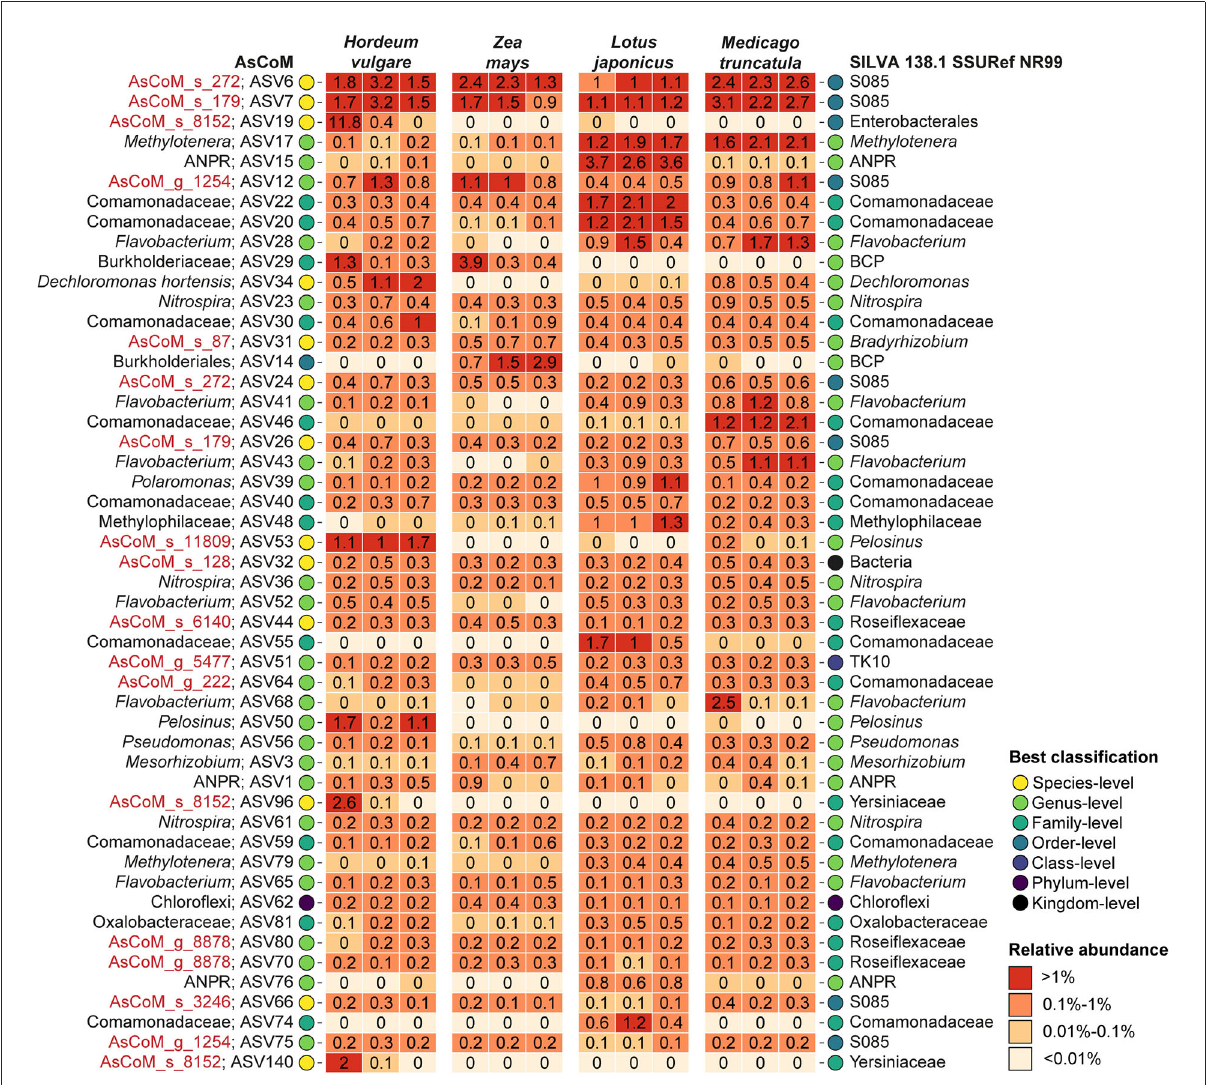
FIGURE4 Classification of the 50 most abundant ASVs in the Askov rhizosphere with four plant types. ASVs were classified with the SINTAX-classifier using AsCoM and the SILVA 138.1 SSURef NR99 database and the best classification (lowest rank) is presented. Three biological replicates are shown for each plant type. De novo placeholder taxa provided by the AsCoM database is highlighted in red. ANPR, Allorhizobium - Neorhizobium - Pararhizobium - Rhizobium ; BCP, Burkholderia - Caballeronia - Paraburkholderia